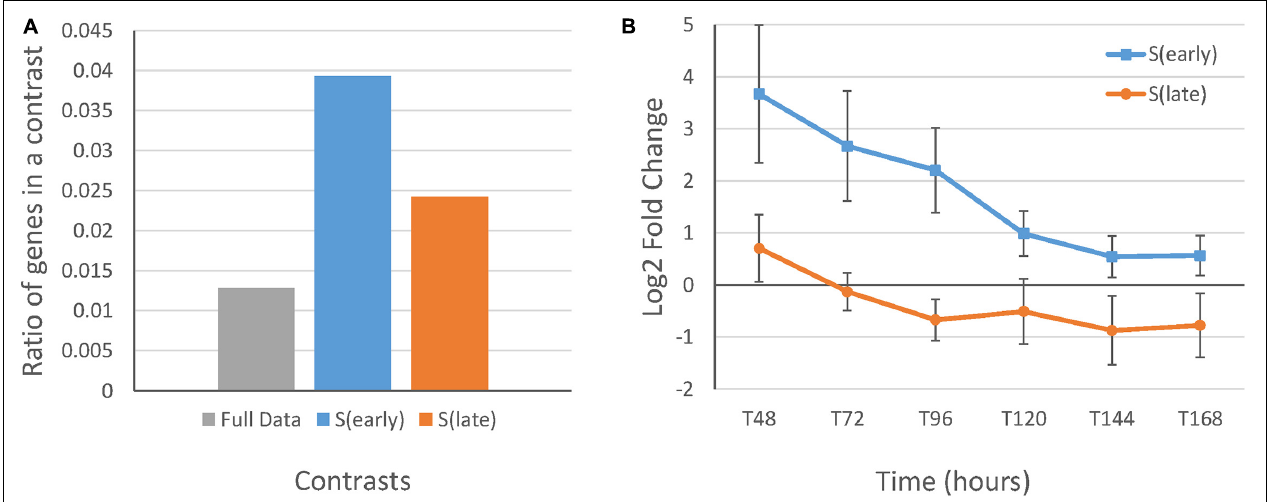
FIGURE 2 | Gene expression and ratios of differentially expressed genes from the S(early) and S(late) results with the COG function “P” compared to those in the full data set. (A) Ratio of genes with the COG “P” (inorganic ion transport and metabolism) in the full data set and the DEG lists of S(early) and S(late). (B) Average log fold-change between the RIB40 control and (cid:49) faaA strains in the DEG lists of S(early) and S(late) with the COG “P” with standard error bars. There were nine genes in the S(early) results and ten genes in the S(late) results ( Supplementary Table 9 ).